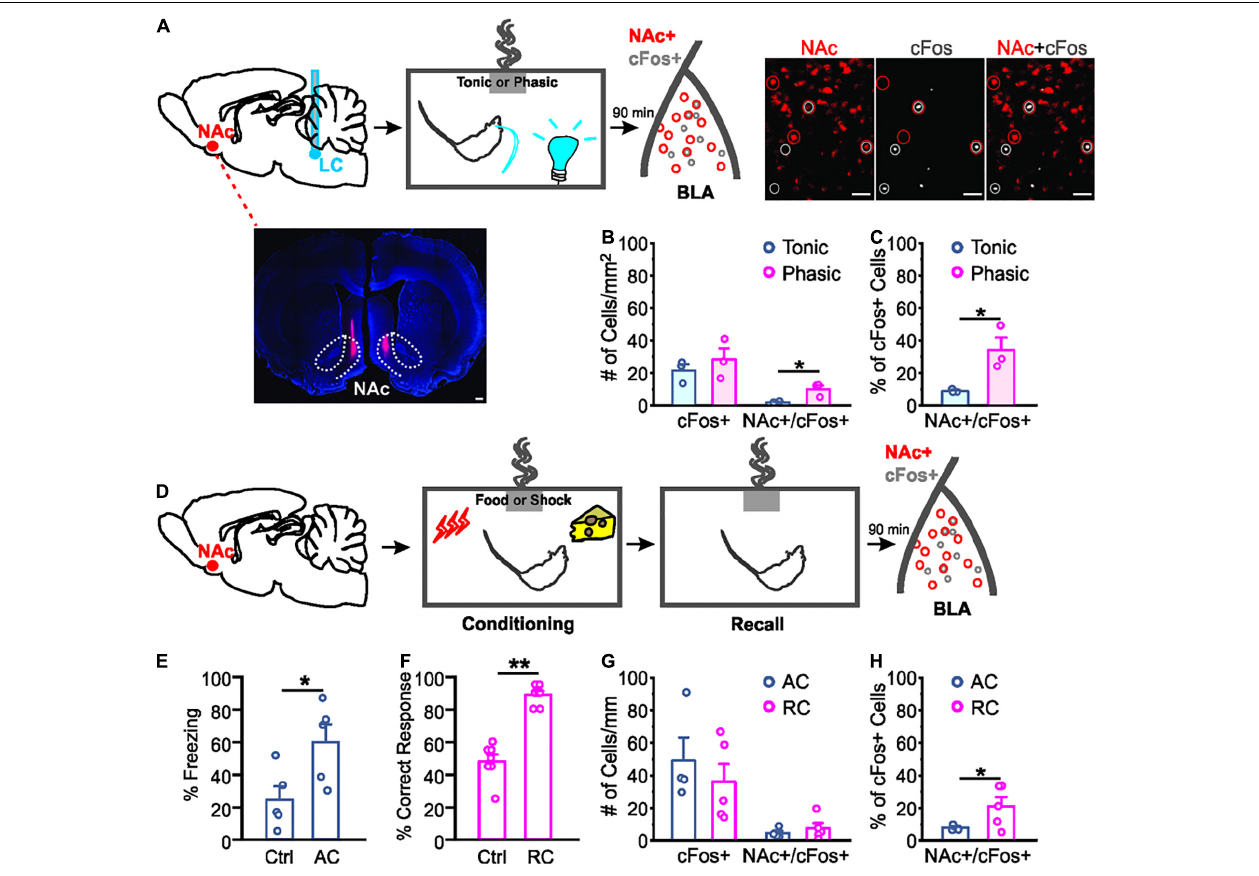
FIGURE 2 | Different activation of nucleus accumbens projecting neurons in the basolateral amygdala by odor valence learning. (A) Schematics of the odor conditioning with locus coeruleus (LC) stimulation in rats with CTB injected in the nucleus accumbens (NAc; dotted lines outline NAc core and shell). Example images of NAc CTB (lower left, scale bar: 500 µ m) and cFos staining (right, scale bars: 50 µ m) are included. (B) Numbers of cFos + cells and NAc-projecting cFos + cells per mm 2 following odor conditioning with light stimulation. (C) Percentage NAc-projecting cells in total active cells (cFos + ) following odor conditioning with photo-activation. (D) Schematics of the odor conditioning with natural stimuli (food or shock). (E) Percentage time spent freezing upon the odor exposure during the testing in odor conditioned rats with shock. (F) Percentage correct response toward the rewarded odor during the testing in odor conditioned rats with food reward. (G) Numbers of cFos + cells and NAc-projecting cFos + cells per mm 2 following different valence odor conditioning. (H) Percentage NAc-projecting cells in total active (cFos + ) cells. AC, aversive conditioning; RC, reward conditioning. * p < 0.05, ** p <